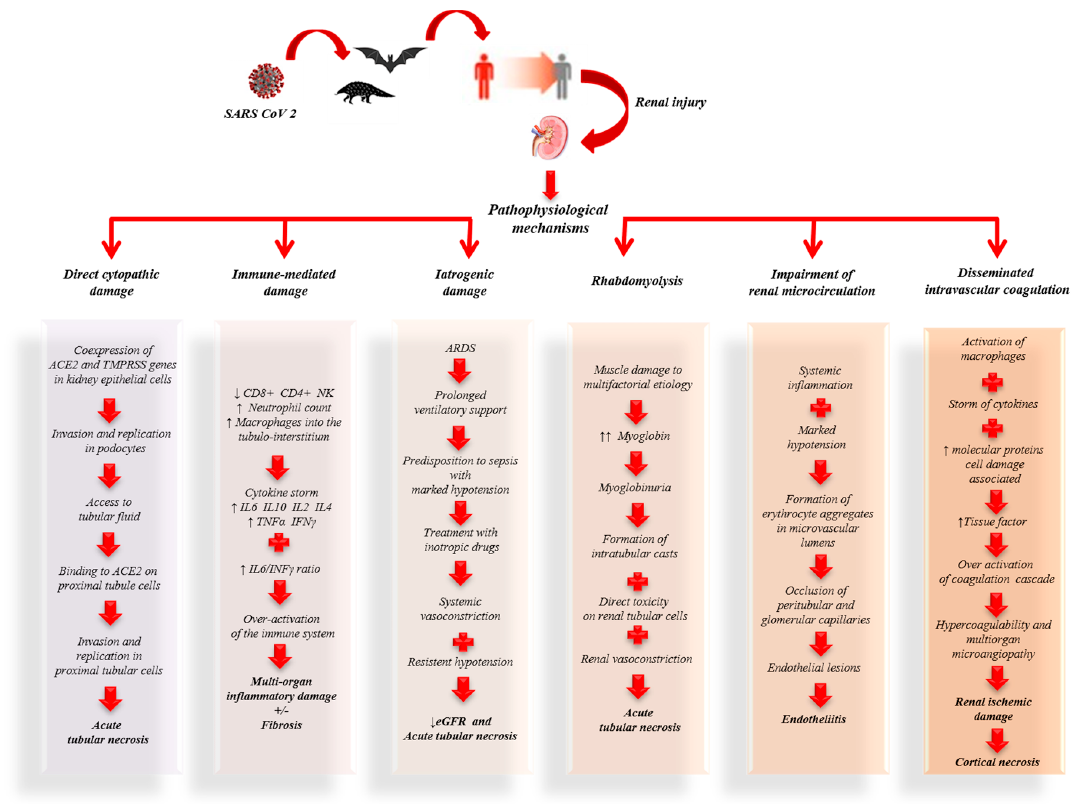
Figure 1. Pathophysiological mechanisms of kidney damage associated with coronavirus disease 2019